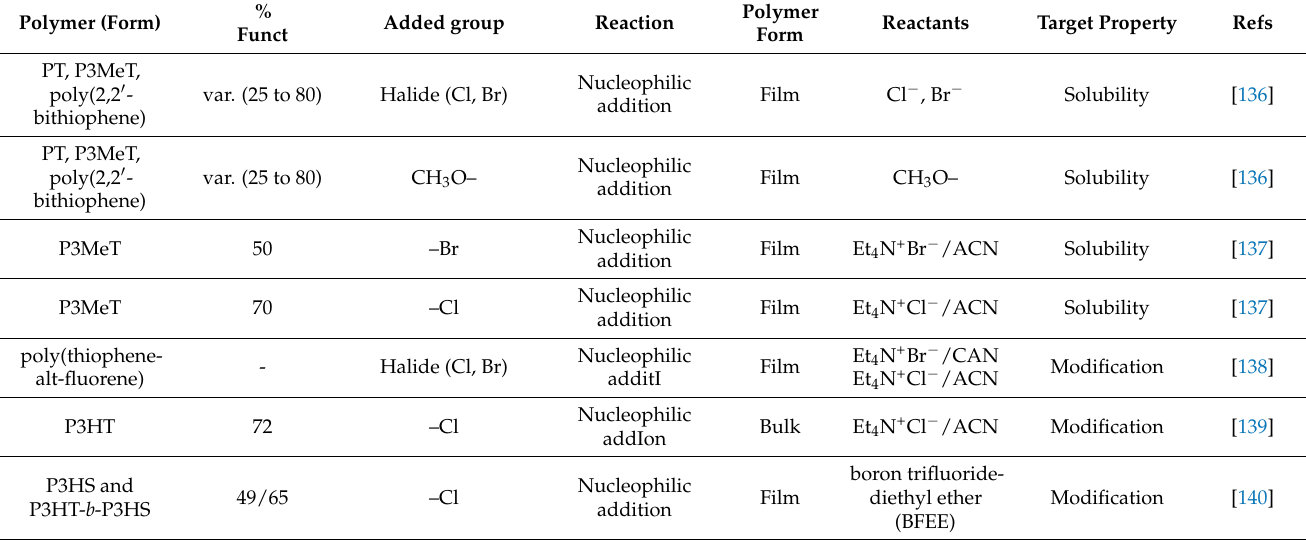
Table 2. Summary of reaction conditions used in PT postfunctionalization.